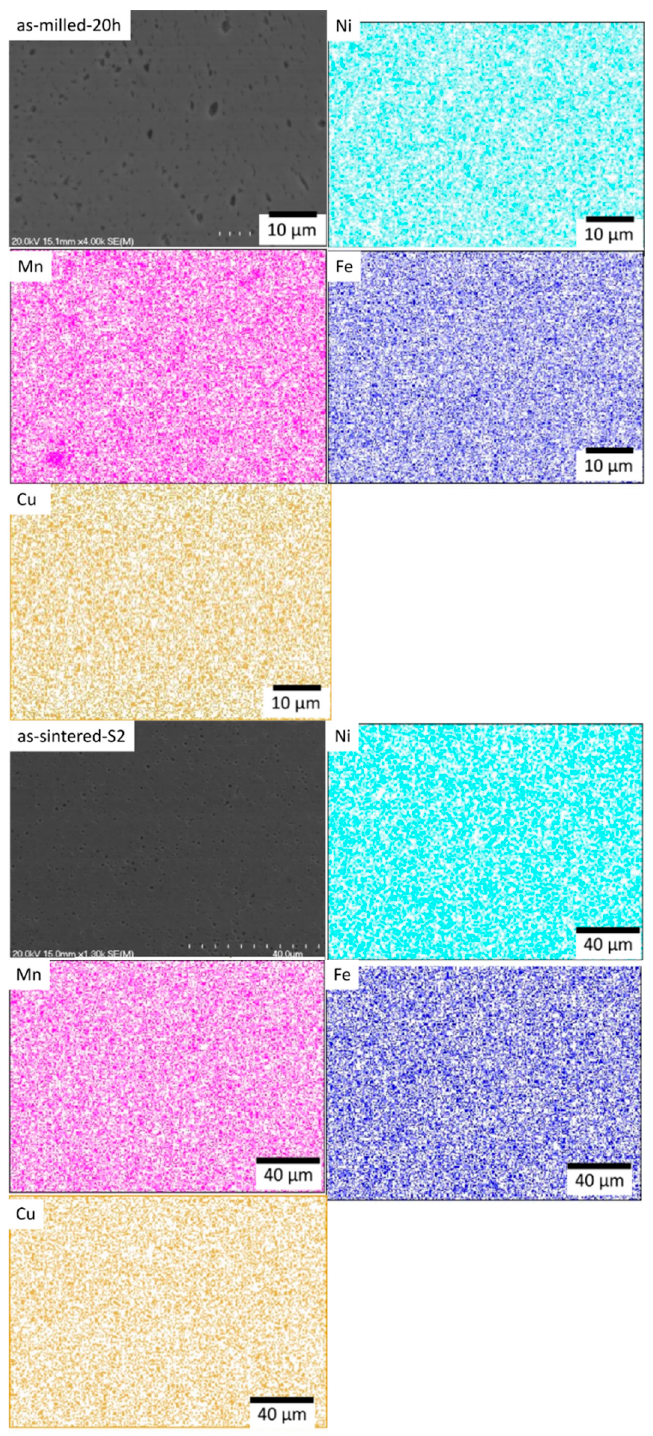
Figure 8. SEM/EDS mapping of the as-milled NiMnFECu powders at 20 h and as-sintered NiMnFeCu alloy at conditions S2 (sintering at 1000 °C for 2 h).